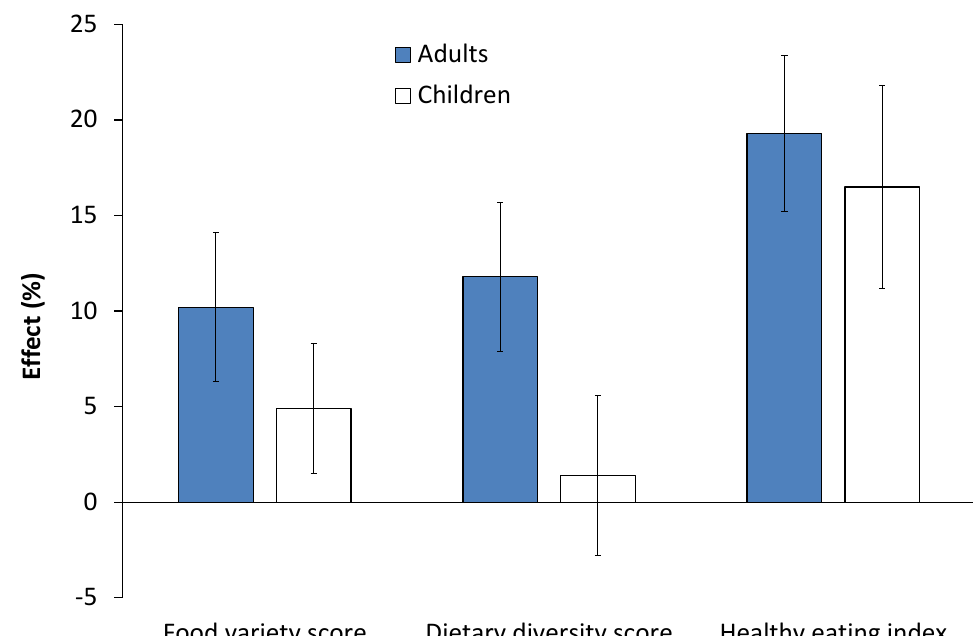
Figure 2. E ff ects of using modern retailers on dietary diversity. Percentage e ff ects are shown with standard error bars. Use of modern retailers expressed as a dummy variable that takes a value of one if any of the food consumed was purchased in a modern retailer and zero if all of the foods consumed were obtained from traditional sources. E ff ects were estimated with control function regression models, controlling for income, education, age, and other relevant factors. Models for adults were estimated with 930 individual observations. Models for children were estimated with 499 individual observations. Full model results are shown in Supplementary Tables S12 and S13.